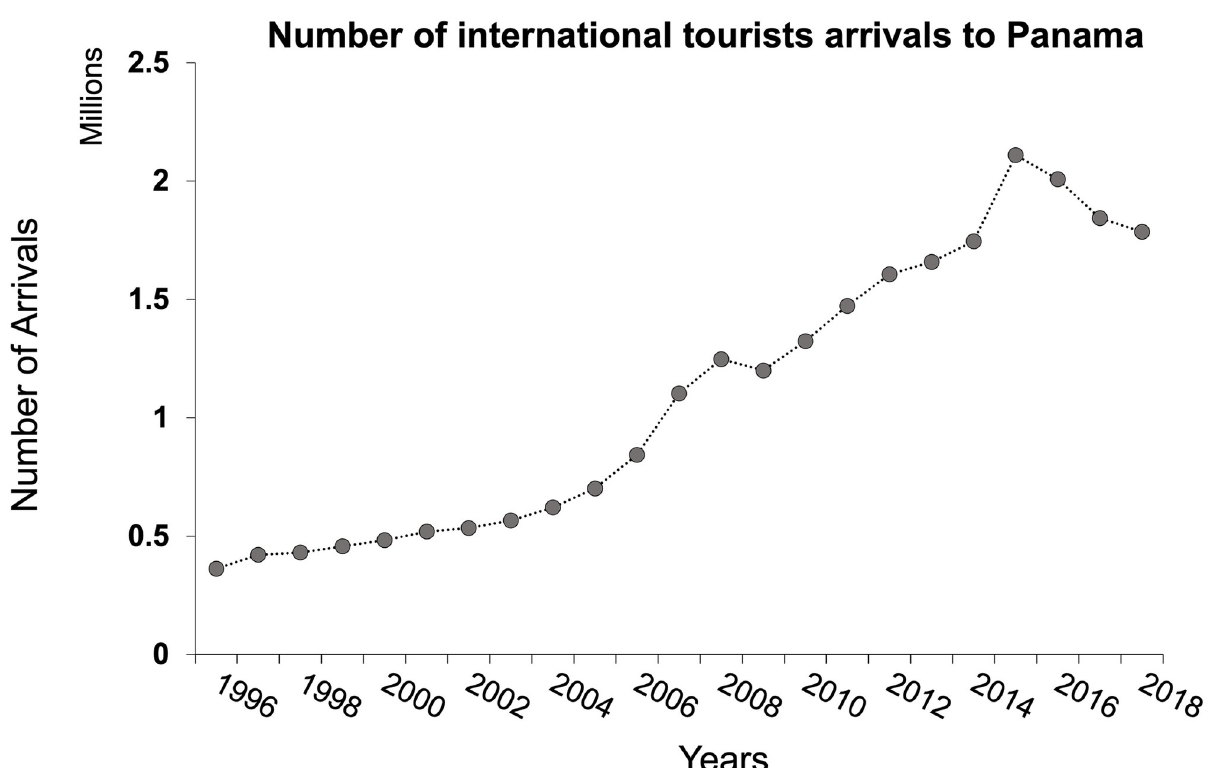
Fig 5. Tourists’ arrivals to Panama. Specific annual numbers of tourist arrivals to the ABT could not be obtained. Source for the figure The World Bank [124].